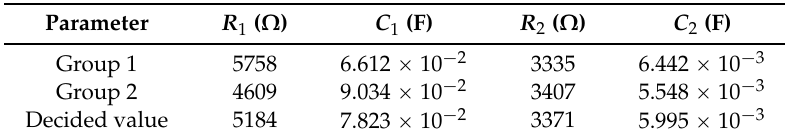
Table 1. Parameters achieved by curve fitting and the final decided value for parameters in built circuit